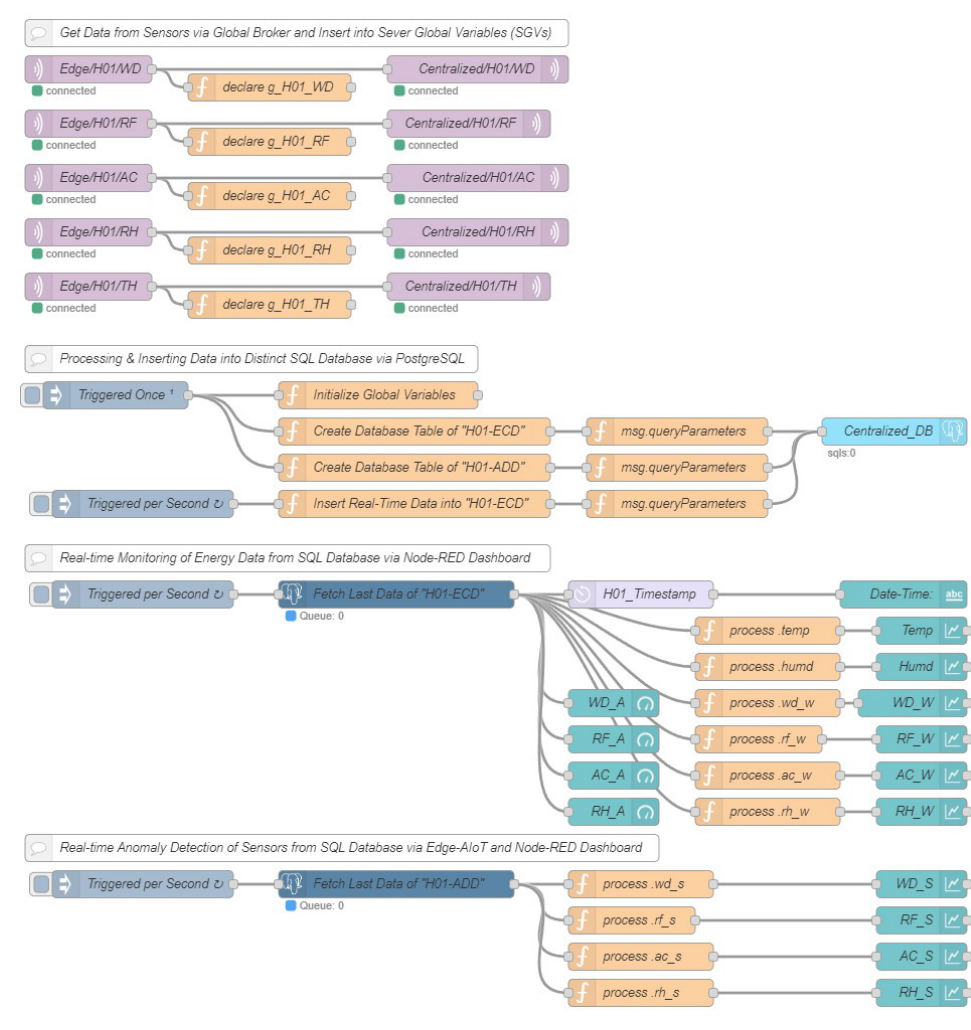
Figure 3. Development of an edge IIoT